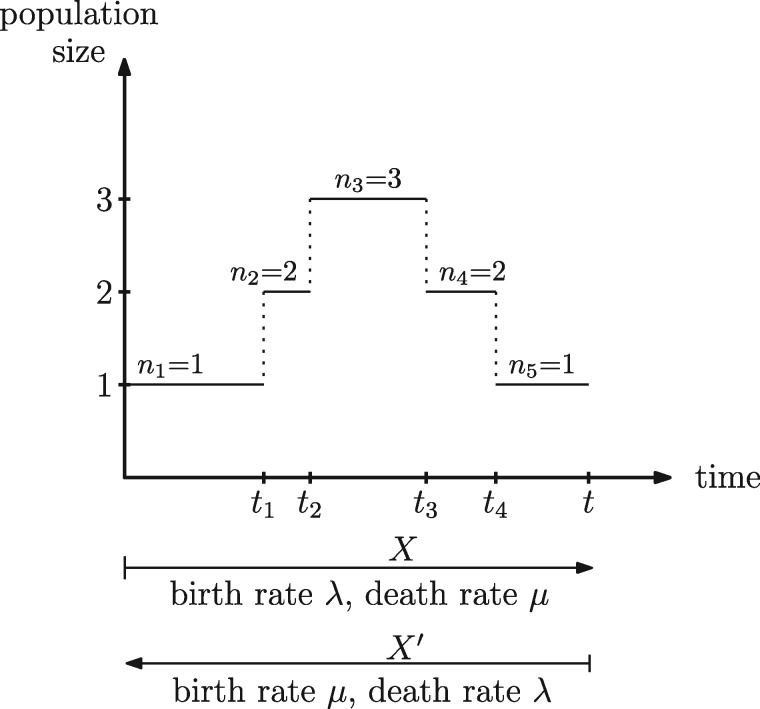
The forward-in-time birth–death process with realization \documentclass[12pt]{minimal}
\usepackage{amsmath}
\usepackage{wasysym}
\usepackage{amsfonts}
\usepackage{amssymb}
\usepackage{amsbsy}
\usepackage{upgreek}
\usepackage{mathrsfs}
\setlength{\oddsidemargin}{-69pt}
\begin{document}
}{}$X$\end{document} and the equivalent time-reversed process with interchanged rates and realization \documentclass[12pt]{minimal}
\usepackage{amsmath}
\usepackage{wasysym}
\usepackage{amsfonts}
\usepackage{amssymb}
\usepackage{amsbsy}
\usepackage{upgreek}
\usepackage{mathrsfs}
\setlength{\oddsidemargin}{-69pt}
\begin{document}
}{}$X'$\end{document}.